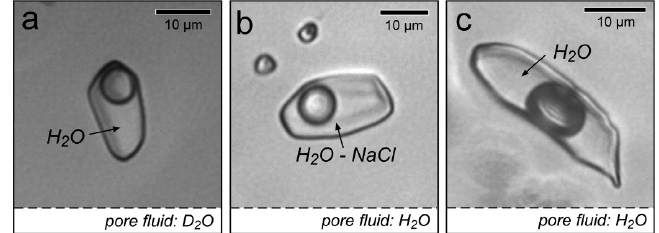
Figure 8. Photomicrographs of synthetic fluid inclusions in three different settings of re-equilibration: ( a ) H 2 O fluid inclusions with a pure D 2 O pore fluid ( GMR-004a ); ( b ) H 2 O-NaCl fluid inclusions with a pure H 2 O pore fluid ( GMR-005a ); ( c ) H 2 O fluid inclusions with a pure H 2 O pore fluid ( GMR-004g ).